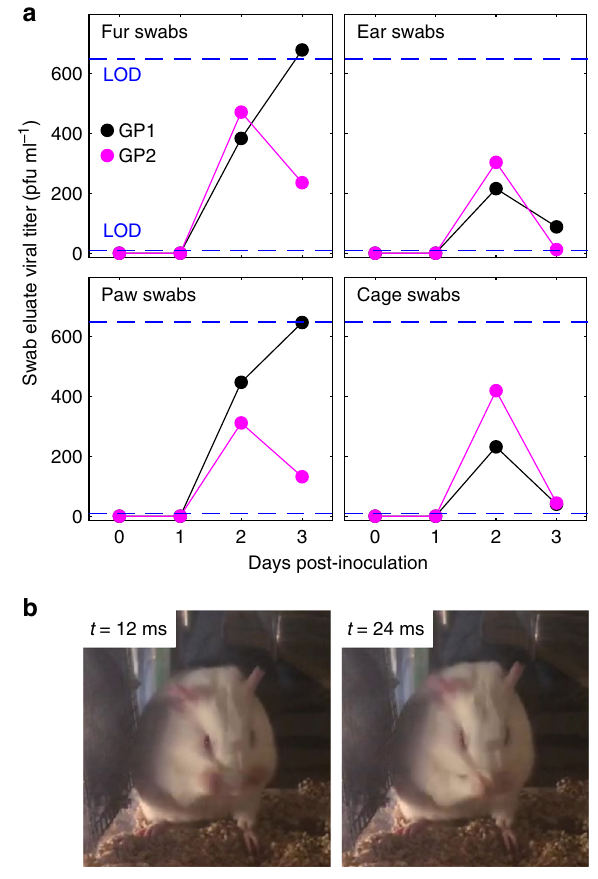
Fig. 2 Infected guinea pigs contaminate their environments with viable in fl uenza virus. a Swab eluate viral titers (in plaque-forming units (pfu) ml − 1 ) from fur, ears, paws, and cages of two separately housed guinea pigs (GP1 and GP2) after intranasal inoculation with Pan99. Two biological replicates (two individual guinea pigs) were performed. One swab per area (fur, ears, paws, and cages) was taken, and one plaque assay per swab eluate was performed (one technical replicate per swab from each biological replicate). Horizontal dashed lines indicate upper (650 pfu ml − 1 of swab eluate) and lower (4 pfu ml − 1 ) limits of detection (LOD) for the titration plaque assays. b An intranasally inoculated guinea pig grooming (Supplementary Movie 1). Source data are provided as a Source Data fi le.